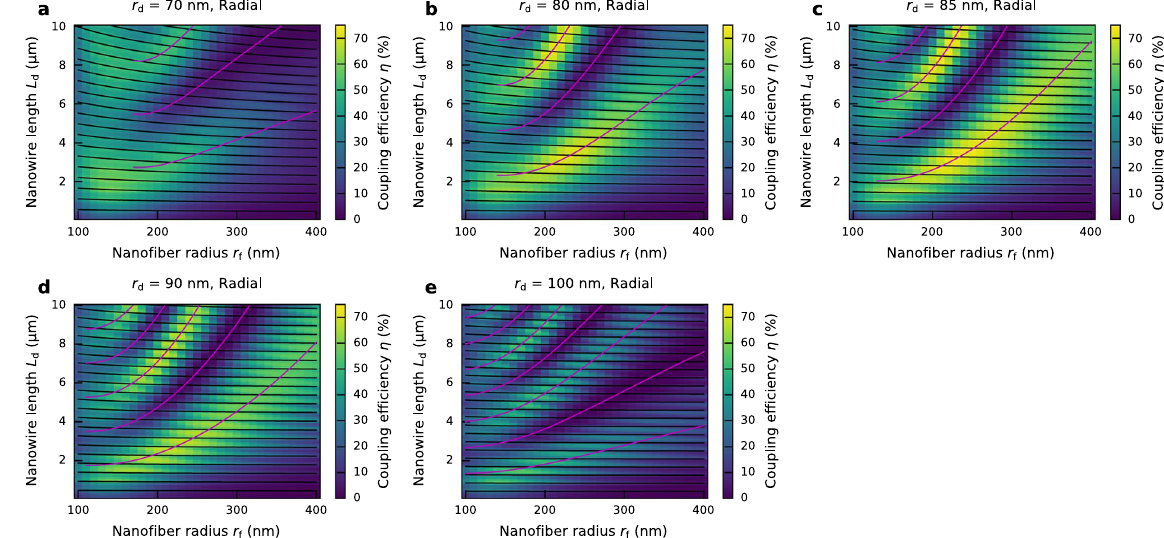
Figure 2. Dependence of the coupling efficiency on the system geometry. ( a ) Coupling efficiency as a function of the nanofiber radius r f and the nanowire length L d for the case of the nanowire radius r d = 70 nm. ( b – e ) Same as ( a ), for the case of the nanowire radius r d = 80 nm, 85 nm, 90 nm, and 100 nm, respectively. The magenta and eff,s(1) eff,s(2) and the Fabry-Perot resonant length black solid lines represent the beat length λ = − L n n /{ } d,beat eff,s(1) , respectively, obtained by the supermode λ = L n / d,FP